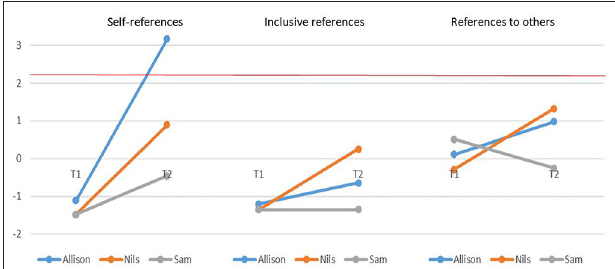
FIGURE 4 | Social references associated with the extended circle: self-references (left), inclusive references (center), and references to others (right) during the first (T1) and second (T2) assessments. The red line represents the pathological cut-off score ( z = 2.179).